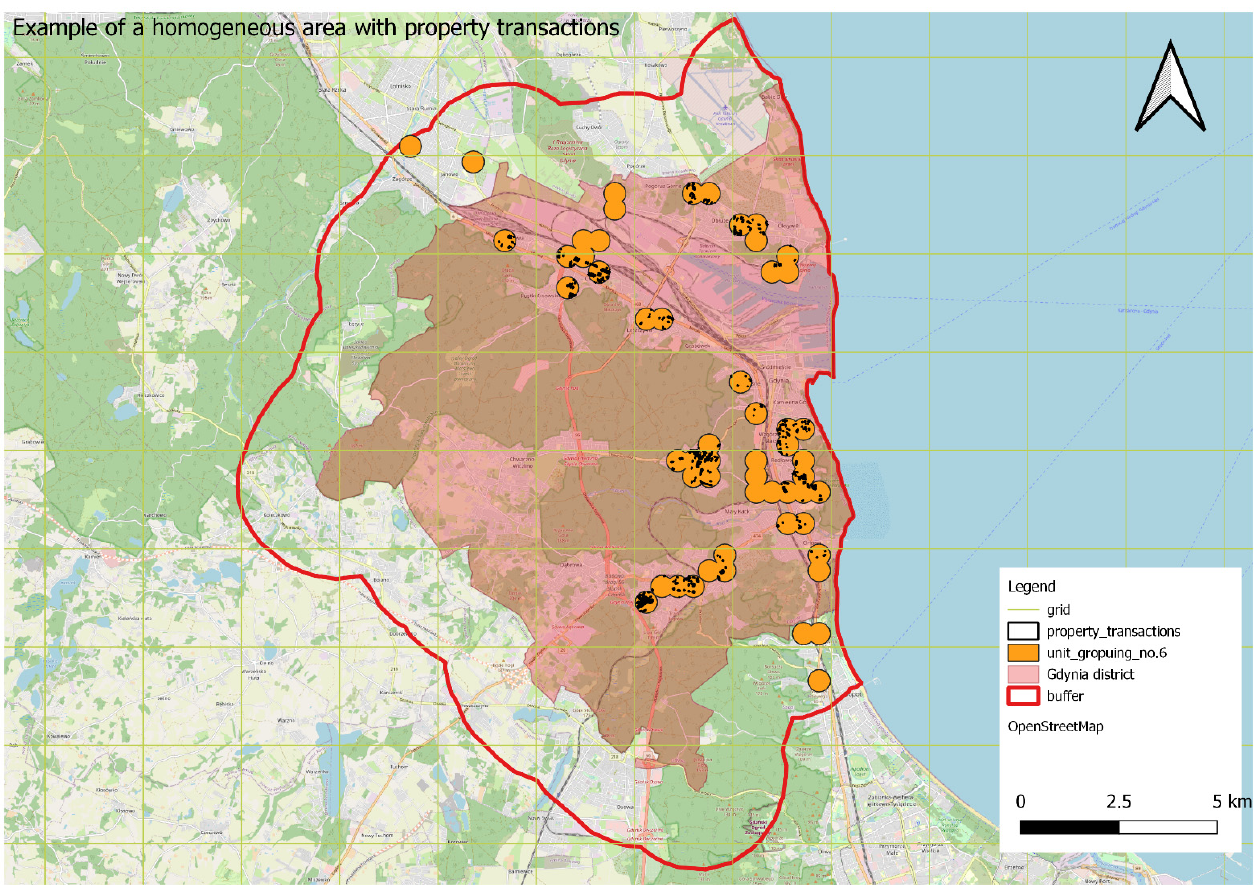
Figure 2. Example of the homogeneous area with property transactions. Source: own elaboration based on Renigier-Biłozor, et al. [58].